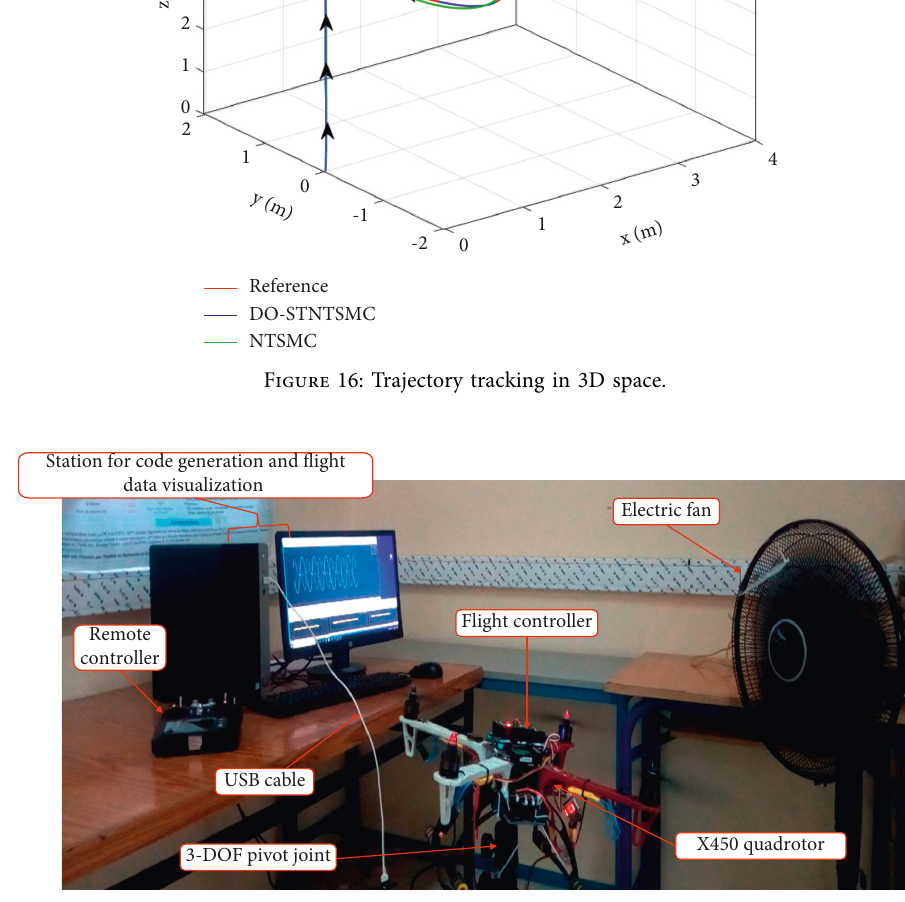
Figure 17: Experimental setup